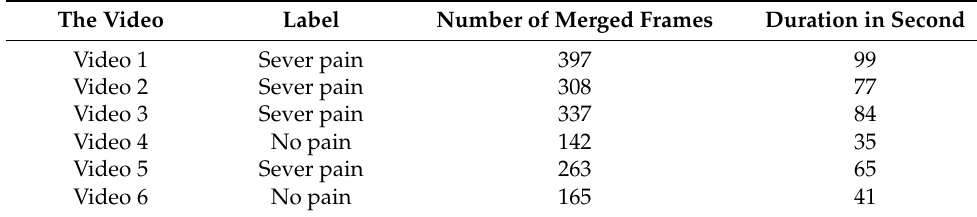
Table 2. Testing videos